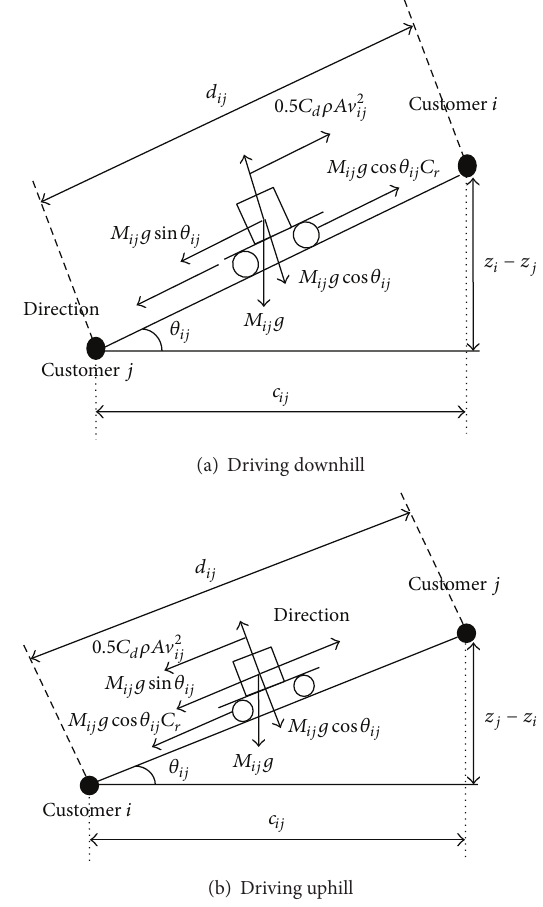
Figure 1: The vehicle driving status when going uphill and